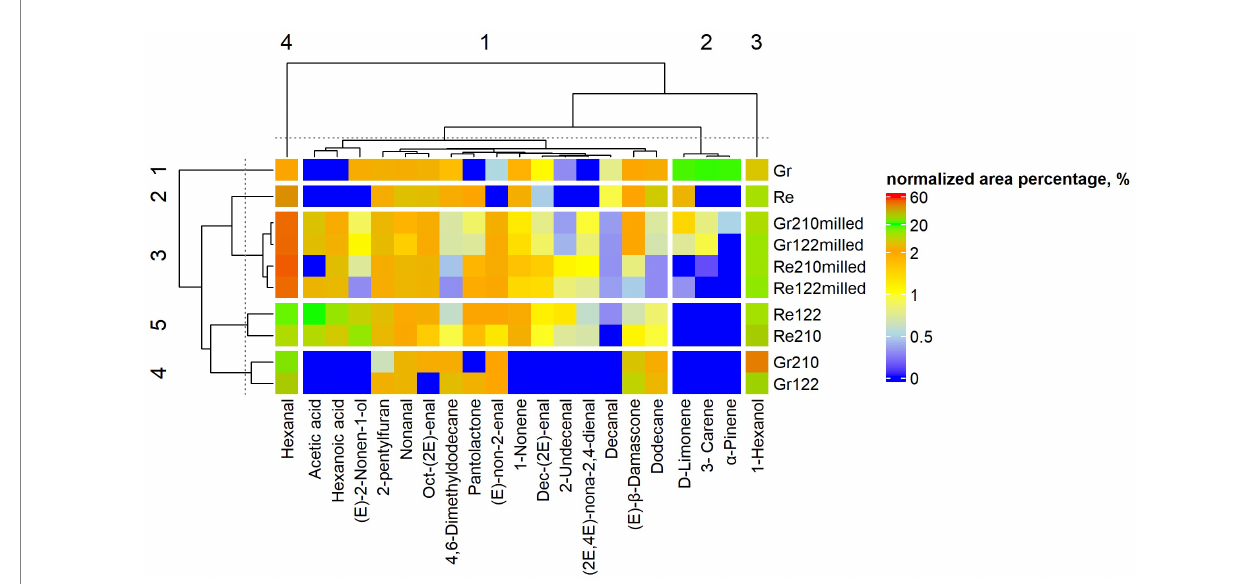
FIGURE 4 Volatile compound (VC) profile (% from the total volatile compounds content) in lentil samples (Re—non-treated red lentils; Gr—non-treated green lentils; 122 —fermented with Lactiplantibacillus plantarum strain; 210 —fermented with Lacticaseibacillus casei strain; milled —milled